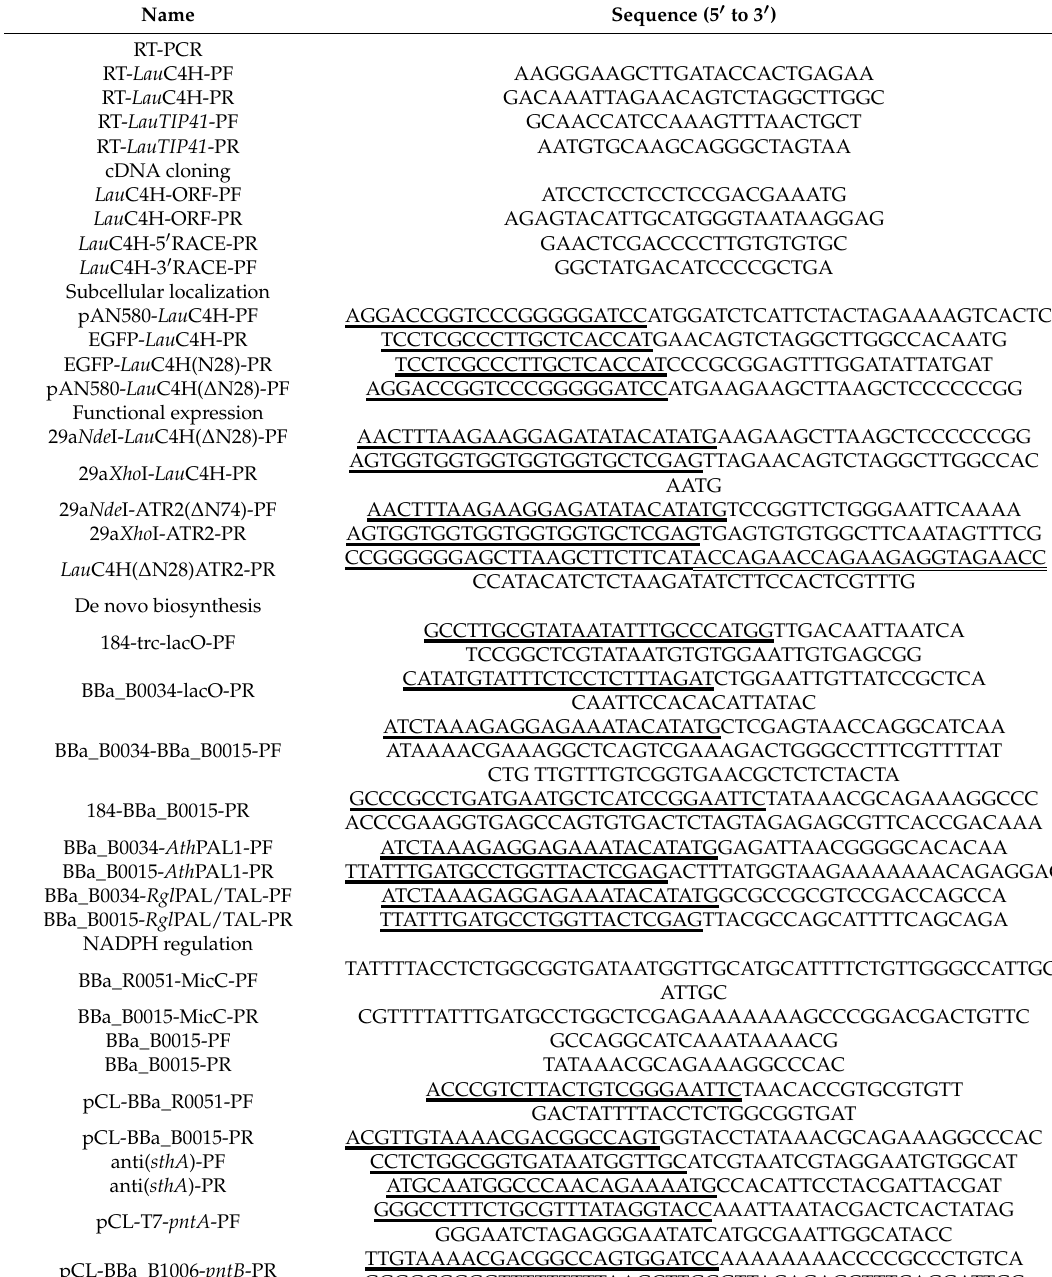
Table A1. Oligonucleotides used in this study.